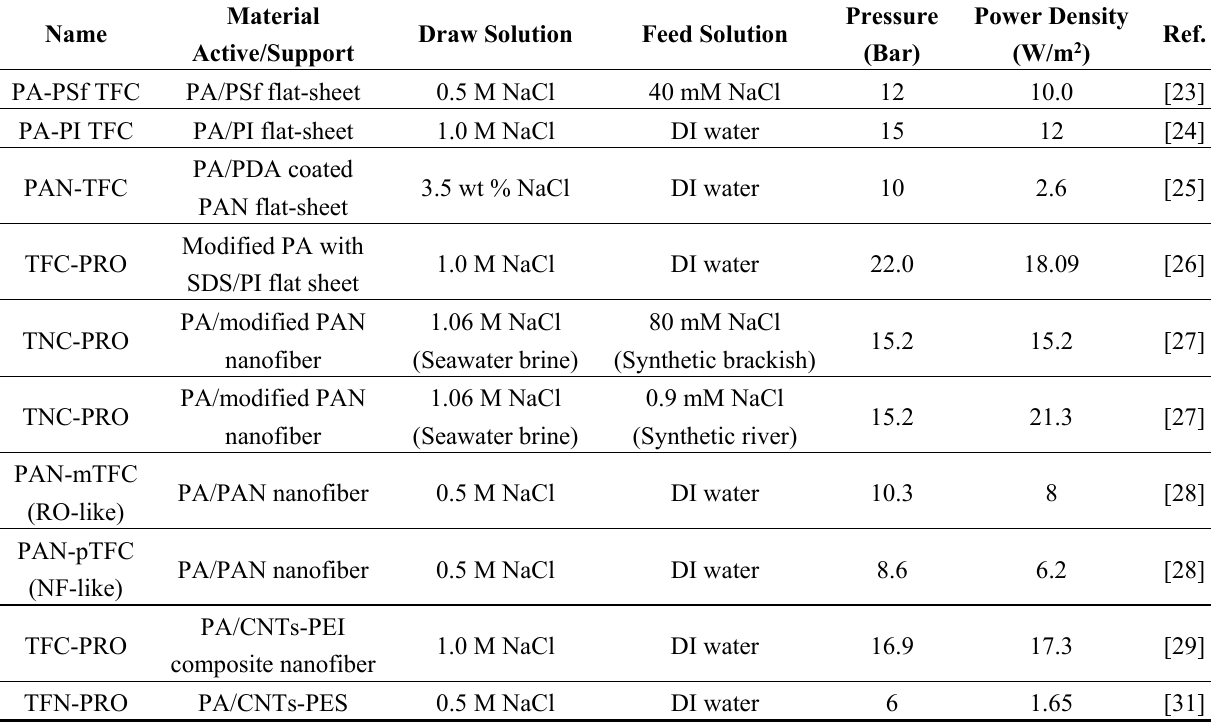
Table 1. Flat-sheet membrane development for